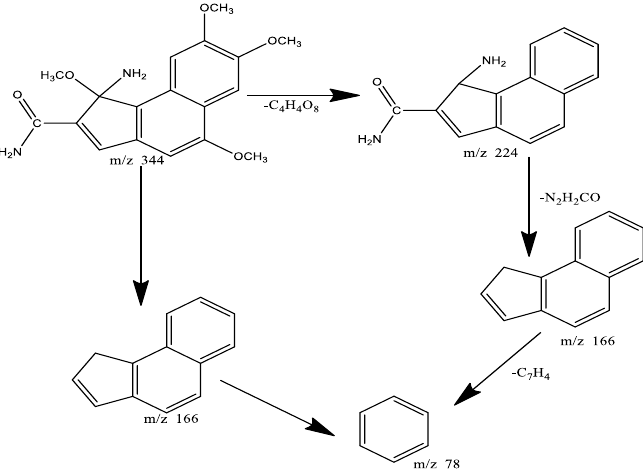
Figure 4. Mass fragmentation of LFD.